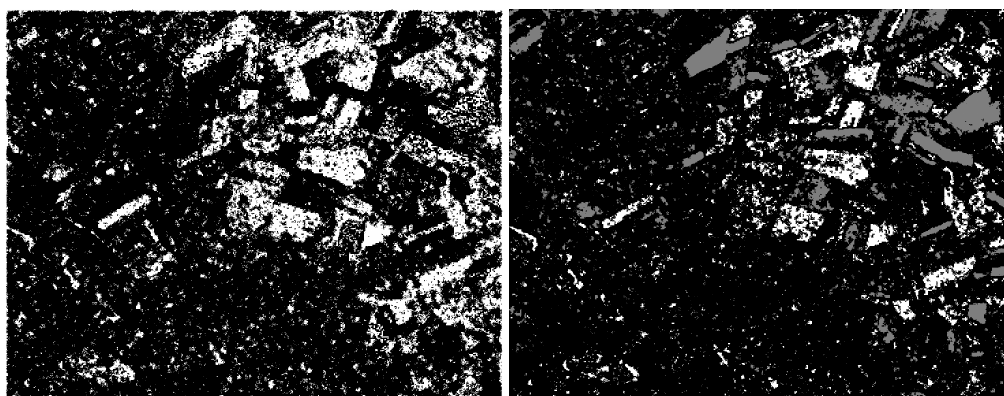
Figure 9. Change maps obtained by applying a formulation of the FDL-ARS method in [15], adapted to the considered multiresolution setup. On the right, the map obtained by applying a double threshold to the log-ratio in order to discriminate both types of change. On the left, the map obtained by applying a single threshold to the normalized log-ratio in order to detect a unique change class. In the latter case, black and white indicate unchanged and changed regions, respectively. For the former case, the legend is reported in Figure